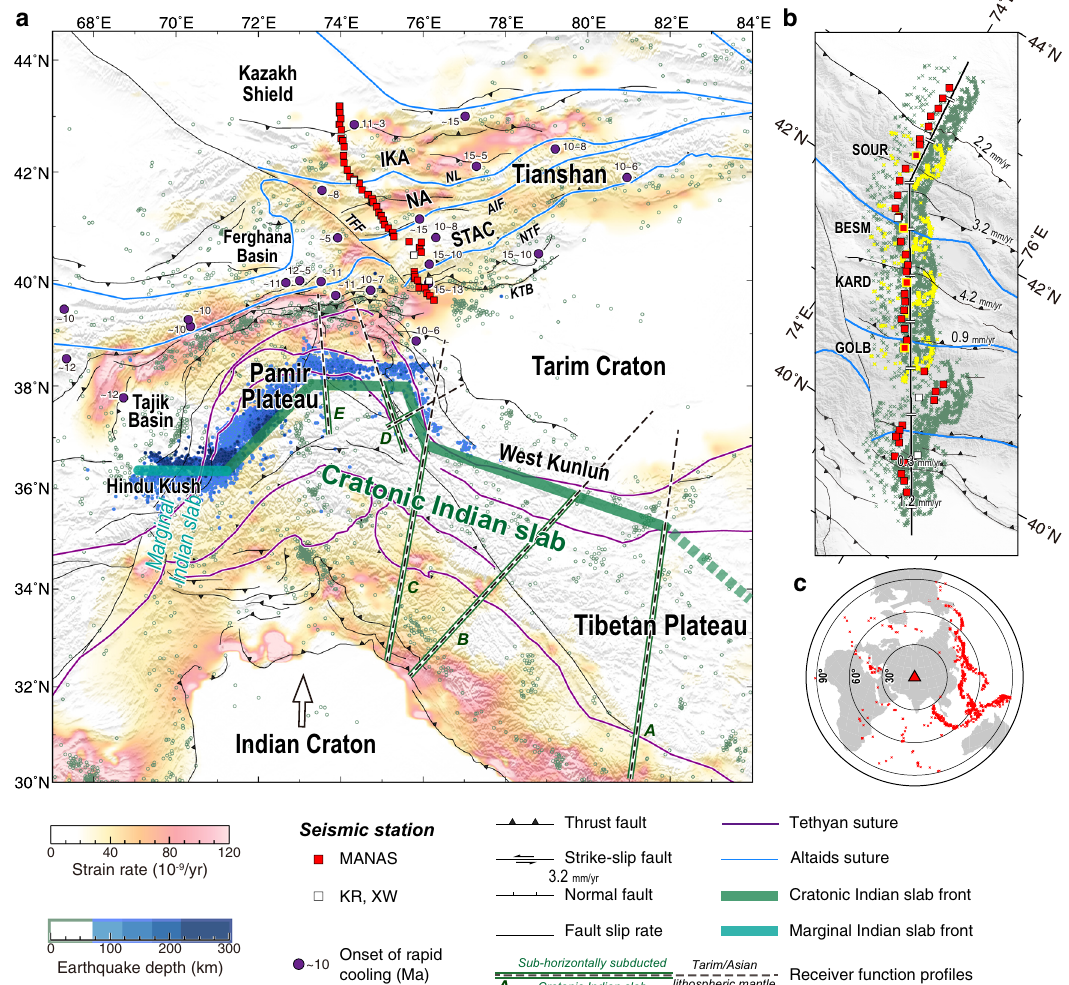
Fig. 1 Tectonic setting of the Tianshan and data coverage of the seismic cross-section. a Tectonic map with strain rates inverted from GPS observations 37 . Squares denote seismic stations used in this study from the Middle AsiaN Active Source project (MANAS) and other networks (KR and XW). Green and blue circles show earthquakes at shallow 65 ( ≤ 70 km) and intermediate 66,67 (70 – 300 km) depths. The purple points with numbers denote the onset of rapid cooling derived from thermochronological studies 13,14 . The present-day northern front of the Indian slab 31,49,66 , including the marginal Indian slab beneath the Hindu Kush and the cratonic Indian slab beneath the Pamir Plateau and the western Tibetan Plateau are together constrained by the interpretations of the previous receiver function pro fi les 29 – 33 (A: Zhao et al. 31 , B: Rai et al. 30 , C: Kumar et al. 29 , D: Xu et al. 33 , E: Schneider et al. 32 ). Sutures in the Altaids and the Tethyan tectonic domain are marked with light blue and purple lines, respectively, and major faults are in black lines (Central Asia Fault Database 68 ). AIF Atbashy-Inylchek Fault, IKA Issyk Kul Arc, NA Naryn Arc, NL Nikolaev Line, NTF North Tarim Fault, KTB Kepingtag Thrust Belt, STAC South Tianshan Accretionary Complex, TFF Talas-Ferghana Fault. b Stations and piercing points of the Ps phases at a depth of 60 km along the cross- section are indicated by solid lines with 50-km scale marks. Numbers denote fault slip rates 28,69 . Sample stations GOLB, KARD, BESM, and SOUR are highlighted by yellow frames, for which inversions are shown in the supplement. c Distribution of events used in this